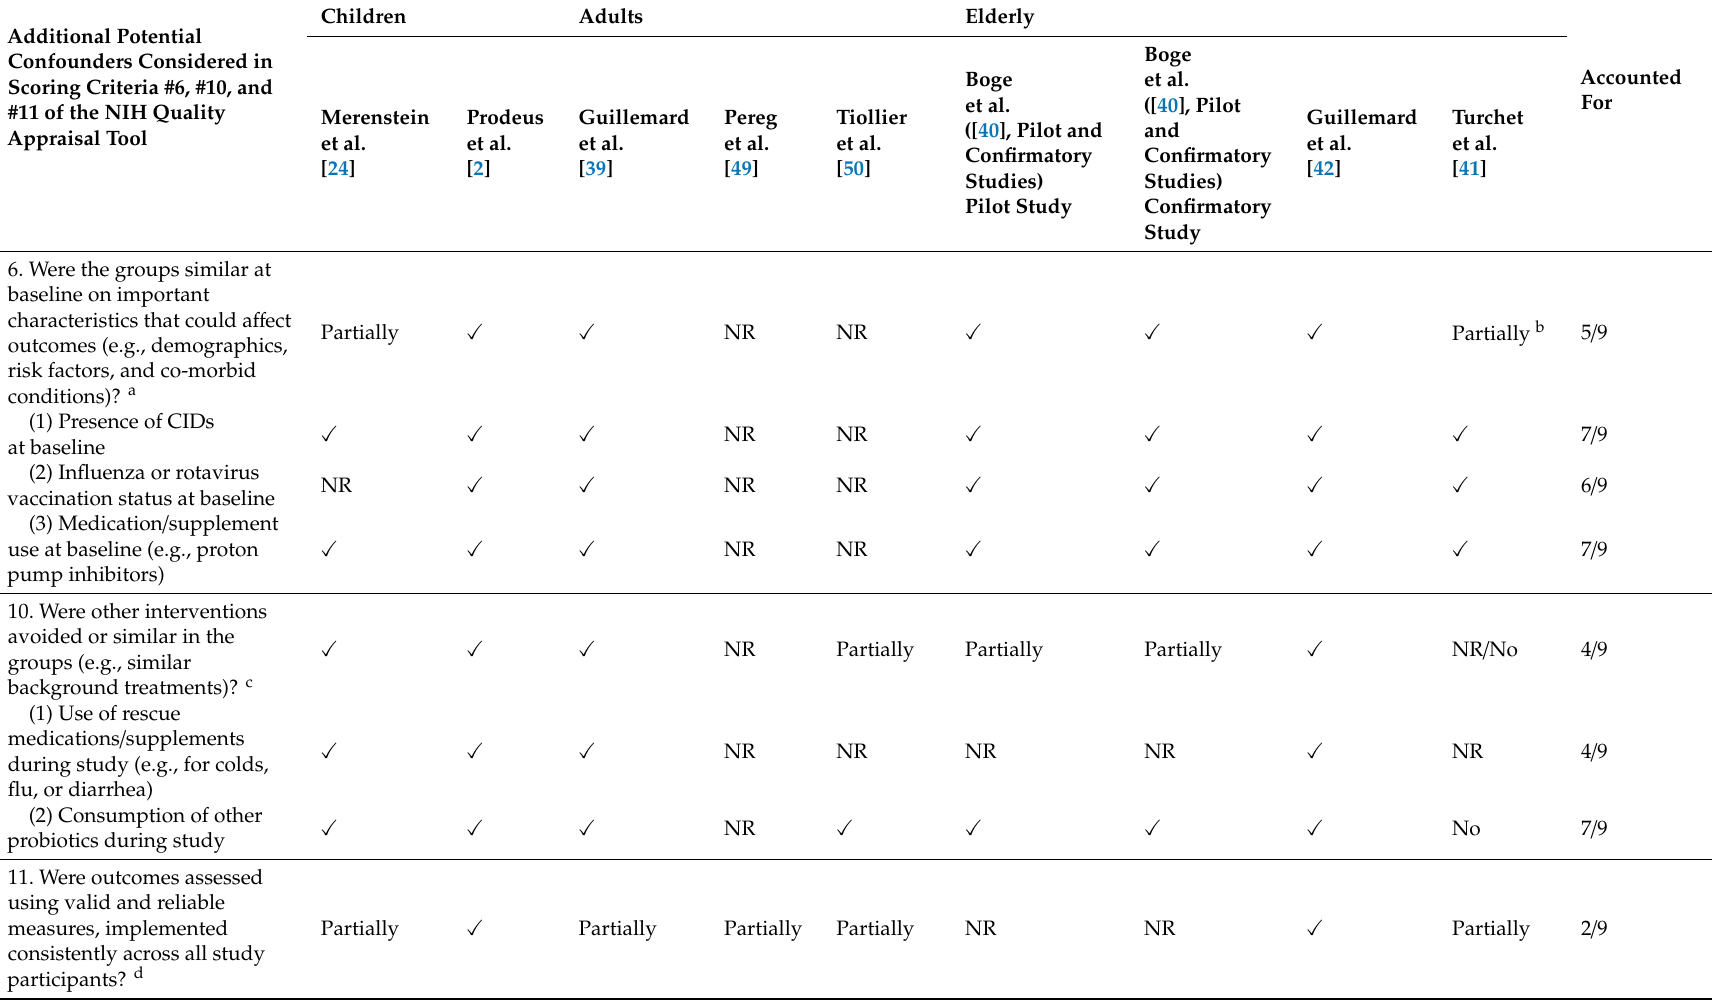
Table 3. Assessment of additional potential confounders pertinent to studies wherein common infectious diseases (CIDs) were